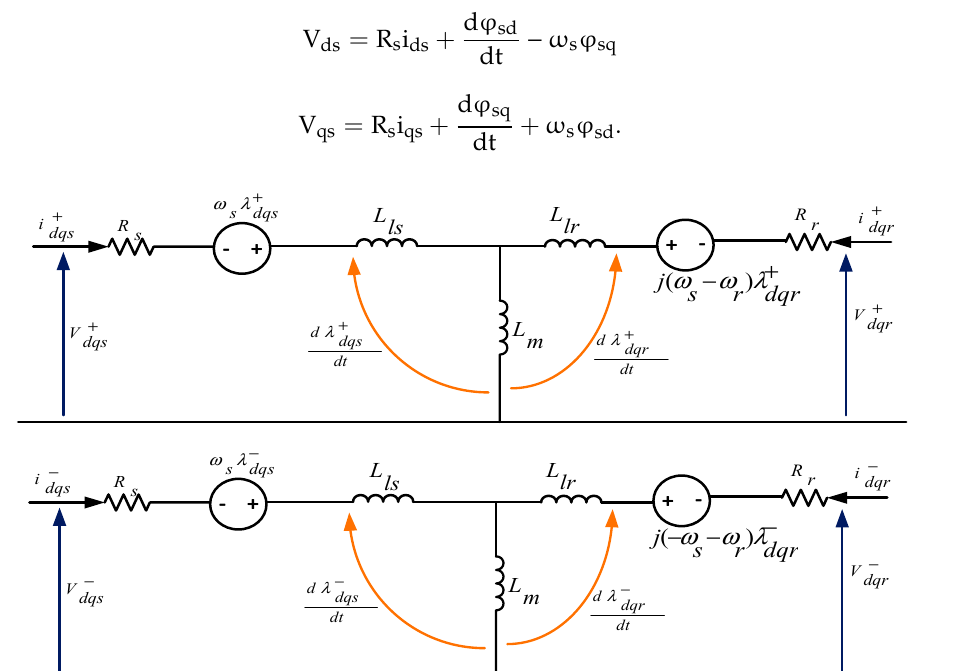
Figure 2. Equivalent circuit of wind based on DFIG for a negative and positive synchronous reference frame.